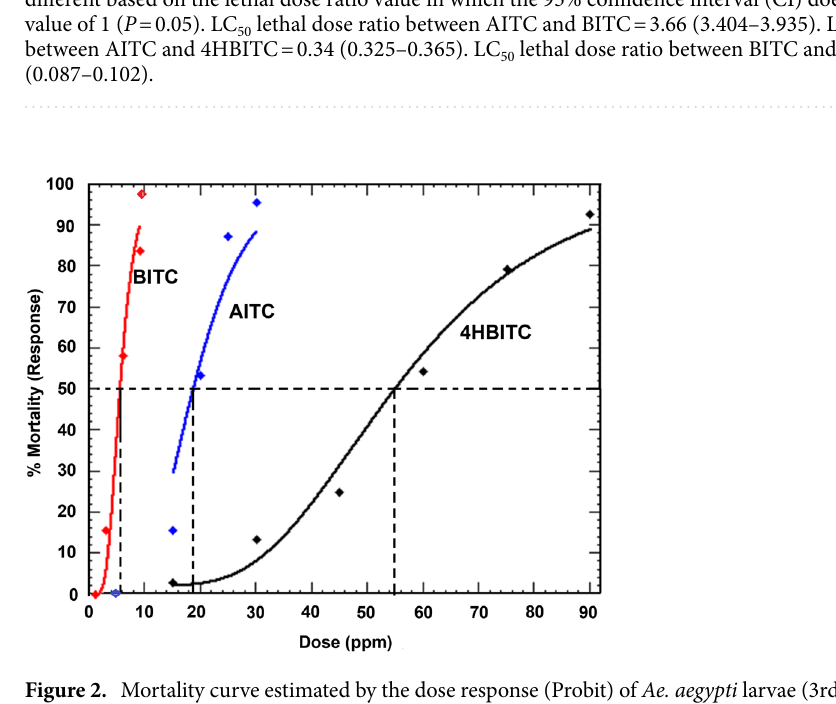
Figure 2. Mortality curve estimated by the dose response (Probit) of Ae. aegypti larvae (3rd larval instars) to synthetic isothiocyanate concentrations 24 h post treatment. Broken lines represent the LC 50 of isothiocyanate treatments. BITC benzyl isothiocyanate, AITC allyl isothiocyanate and